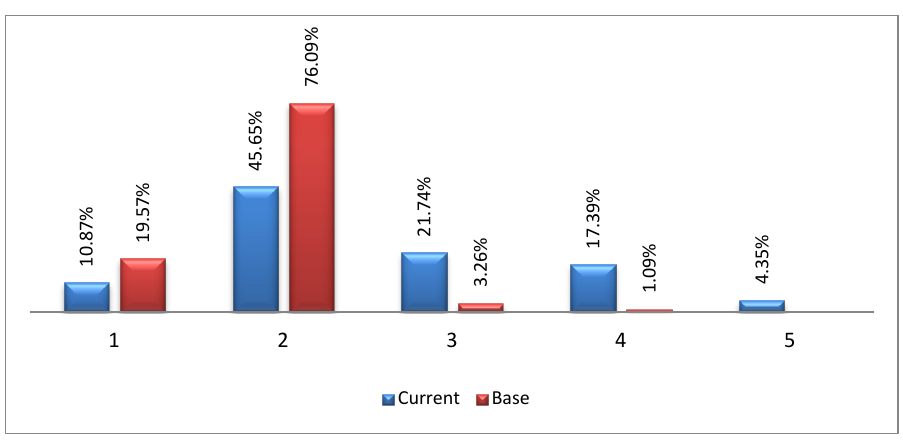
FIGURE 5(b): Harmonisation of integrated reporting